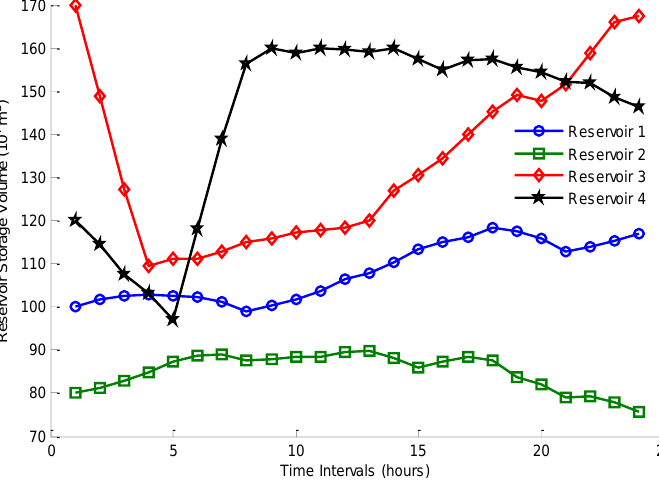
Figure 3. Performance characteristics of EPC and EEP with DOGSA for MSHTS of Test System-I. In MSHTS, the proposed NSDOGSA approach is optimized for both the EPC and EEP simultaneously, and obtained non-dominated solutions are shown in Table 4. The selection of feasible solutions among trade-off solutions is obtained with the help of a fuzzy decision-making approach. Figure 4 and Table 5 show the complete MSHTS sched- ule for the selected feasible solution. Bold font values indicate the best optimal MSHTS solution using a fuzzy decision strategy.